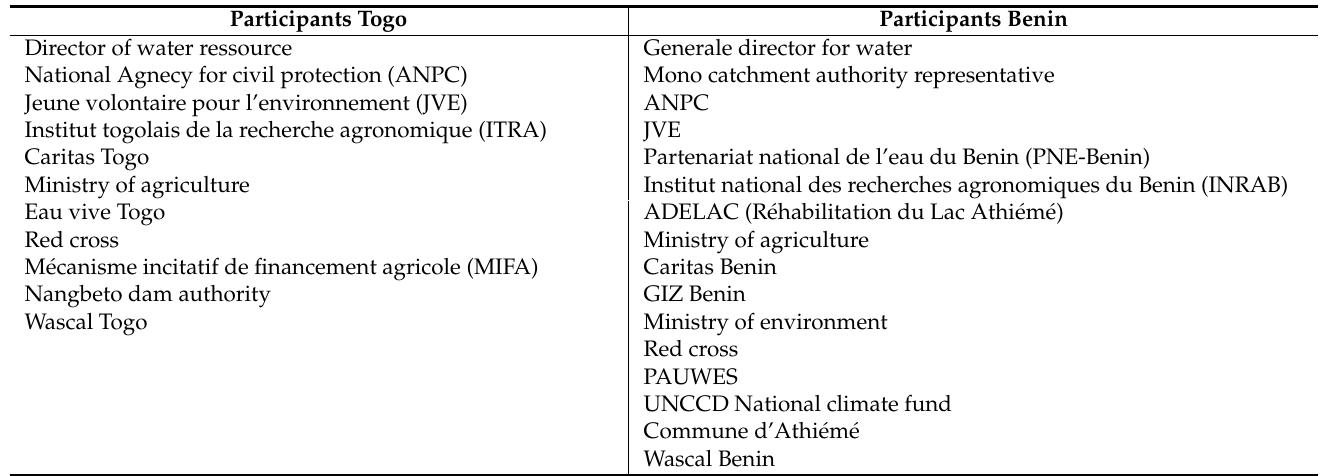
Table A1. List of institutions who participated in the